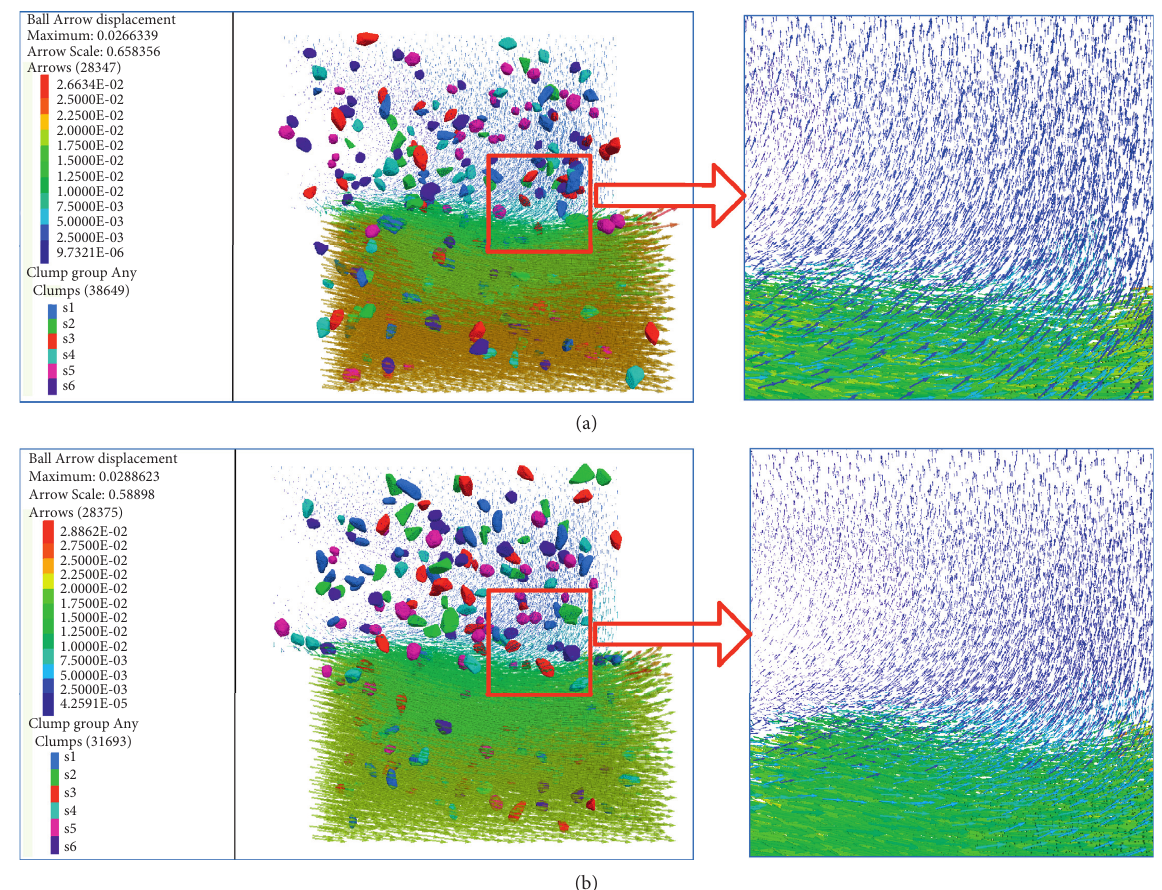
Figure 8: The phenomenon of rock around the displacement vector field of numerical sample. (a) RSAM displacement field. (b) SBSM displacement